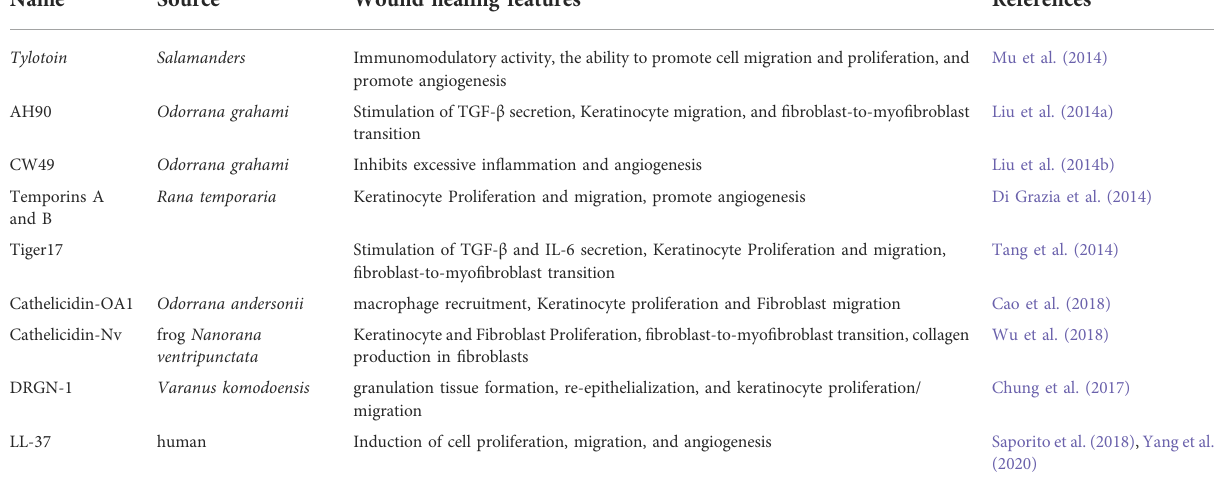
TABLE 1 Natural and synthetic antimicrobial peptides in wound